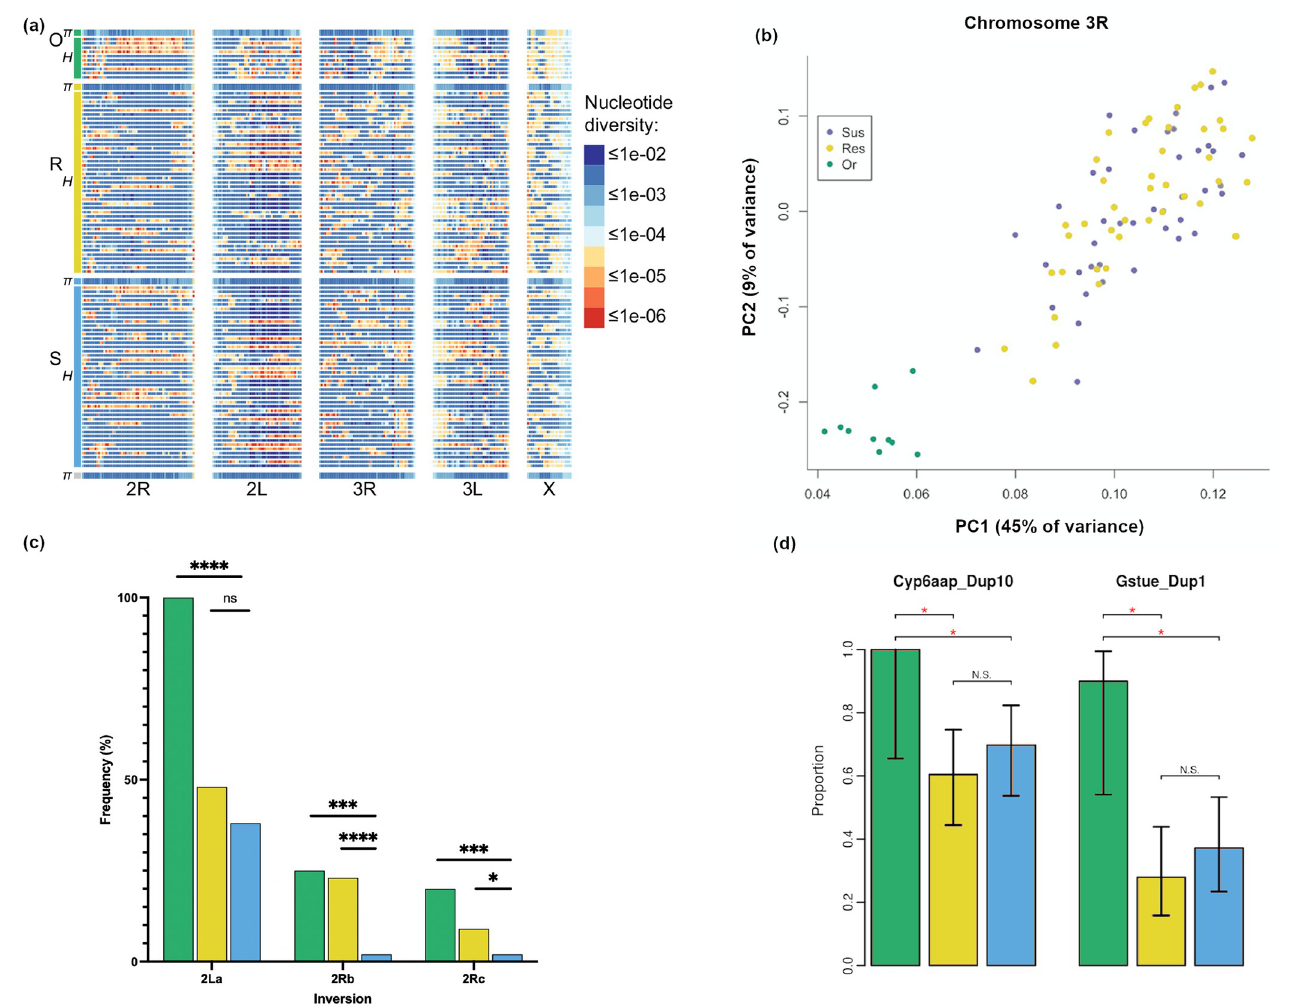
Fig 3. Whole genome sequence results. In each image Banfora-O is green and Banfora-R is yellow Banfora-S is blue. (a) Nucleotide diversity per population ( π ) and per individual (heterozygosity, H) along the length of each chromosome in 1 Mb windows. Diversity is similar among populations and overall (grey at bottom) but is heterogeneous along chromosomes suggestive of large haplotype blocks (b) PCA plot of chromosome 3R, chosen to represent the autosomal genome outside of large inversions (c) Frequency of inversion status in each population (d) Gene duplication scans showing the proportion of each population containing the two detected duplications. Significance calculated by Fisher’s exact test. � = p < 0.05, ��� p < 0.001, ���� p < 0.0001, ns. indicates non-